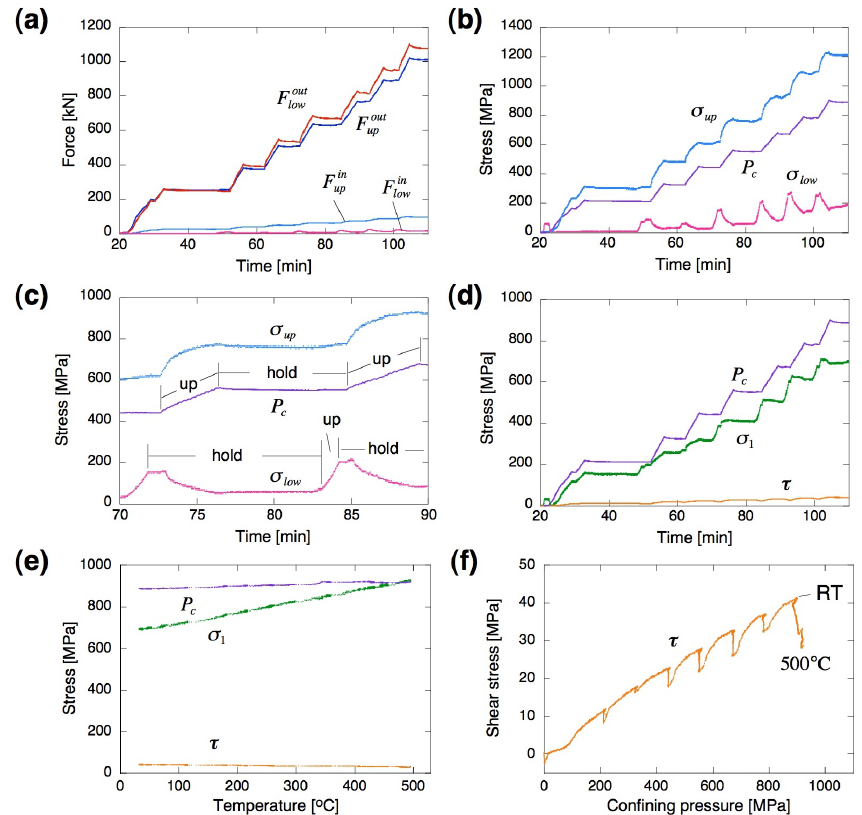
Figure 6. Mechanical data acquired in the pressure stepping test (S01). ( a ) Force data recorded by the upper and lower load cells. ( b ) Apparent axial stresses σ up and σ low and confining pressure P c calculated from the force data. ( c ) Enlarged view of ( b ). ( d ) True axial stress σ 1 and average shear stress τ on the cylinder core. ( e ) Change in mechanical data during the heating test. ( f ) Variation in shear stress τ with P c during the pressure step test and the heating test. RT: room temperature. All data are from experiment